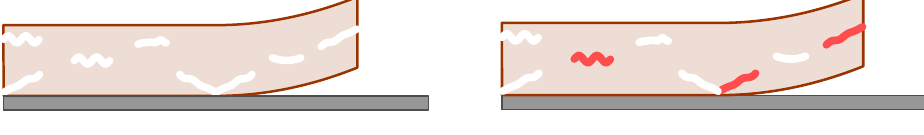
Figure 2. Schematic representation of the continuum damage-healing mechanics: ( a ) Partly damaged coating (0 < d < 1); ( b ) Damaged coating after the healing events: a new value d (cid:48) of the damage variable is obtained, with 0 < d (cid:48) < d and 0 < h < 1. For the sake of the illustration, h = 1 represents full recovery of the damage and the healed microcracks are coloured in